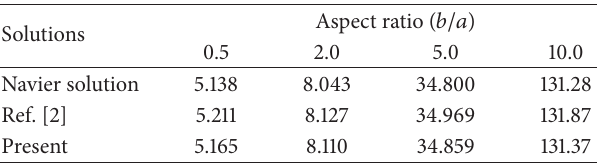
Table 8: Nondimensional buckling loads of FGM simply supported = 𝑁 𝑏 2 /𝐸 ℎ 3 , 𝑝 = 10) . plates (𝑁 2 cr cr